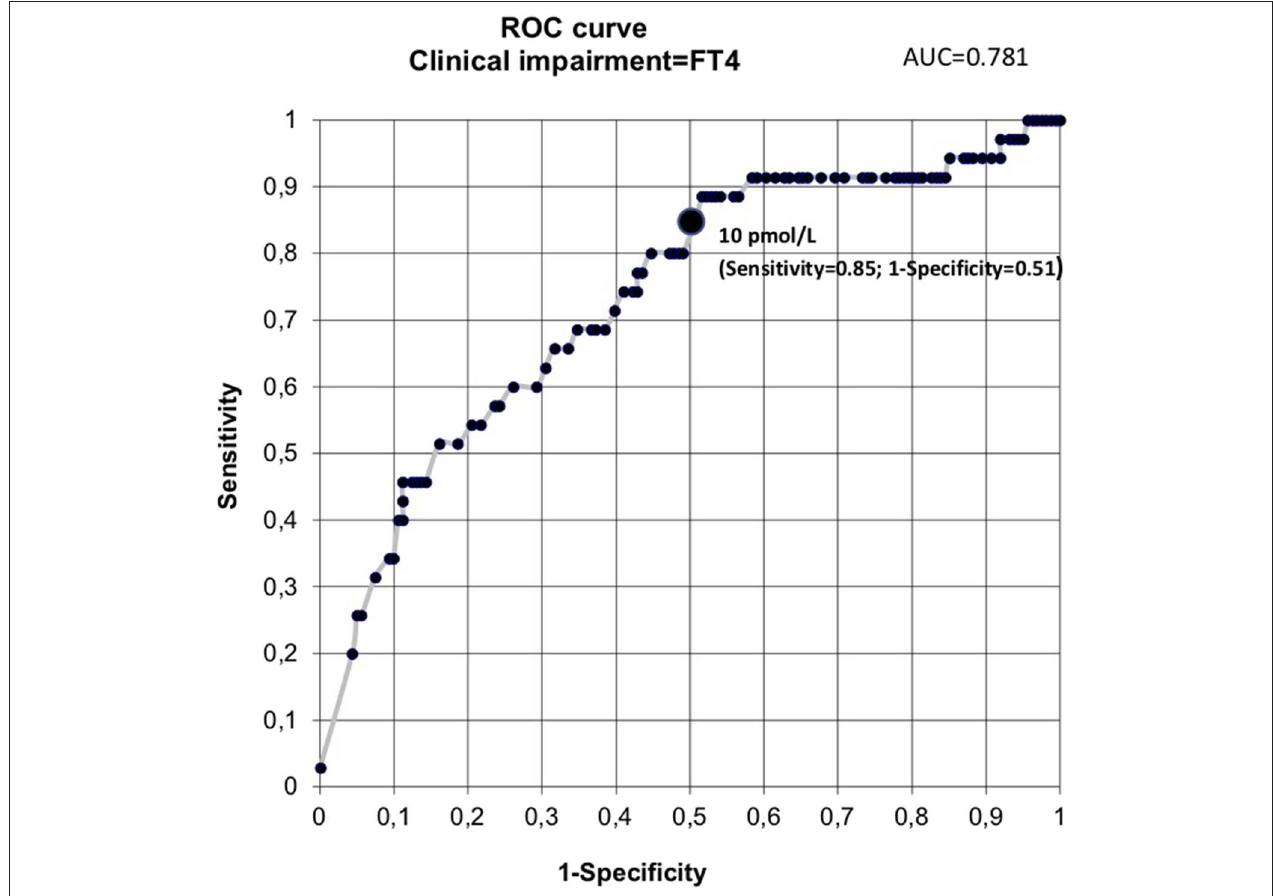
FIGURE 2 | Receiver operating characteristic curve analysis. AUC, area under the curve; FT4, free